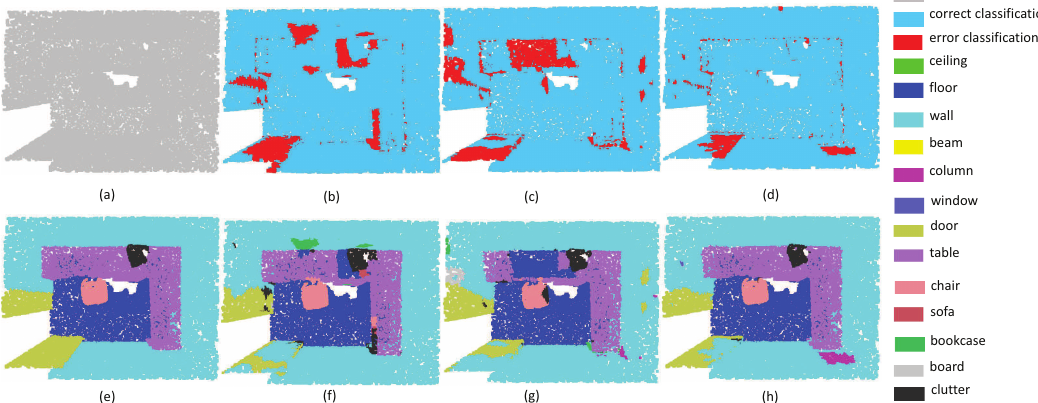
Figure 15. The segmentation results on Of ficeS 3 D 1. ( a ) input, ( e ) ground truth, ( b , f ) the classification result by PointNet++, ( c , g ) the classification result by PointSIFT, and ( d , h ) the classification result by SAN.